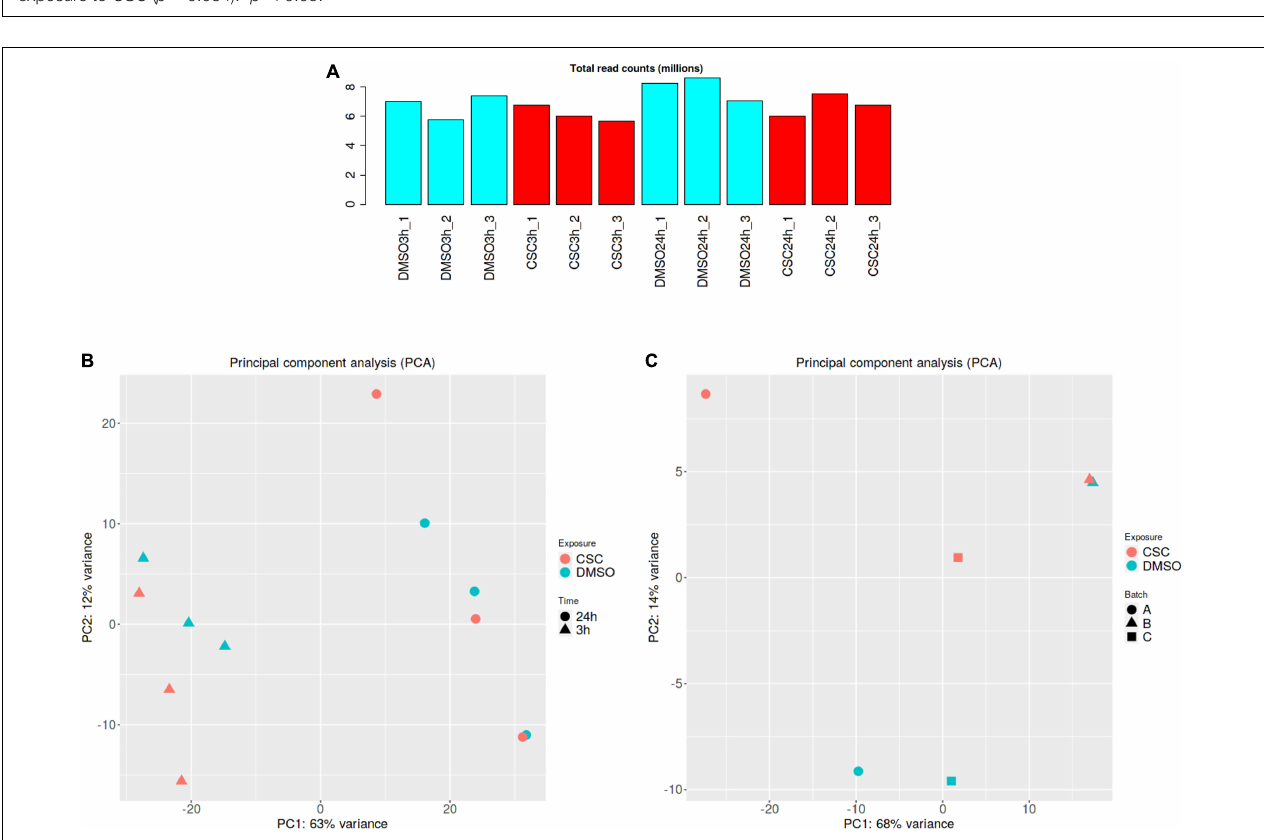
FIGURE 2 | RNA-seq analysis. (A) Total read count per million for all samples. (B) PCA separated by CSC exposure followed by time for all the samples (C) PCA for 24-h samples indicating divergence of the batch B samples (batch A = replicate 1, batch B = replicate 2, and batch C = replicate 3). DMSO samples are indicated in blue and CSC in red. Graphs were generated using the iDEP91